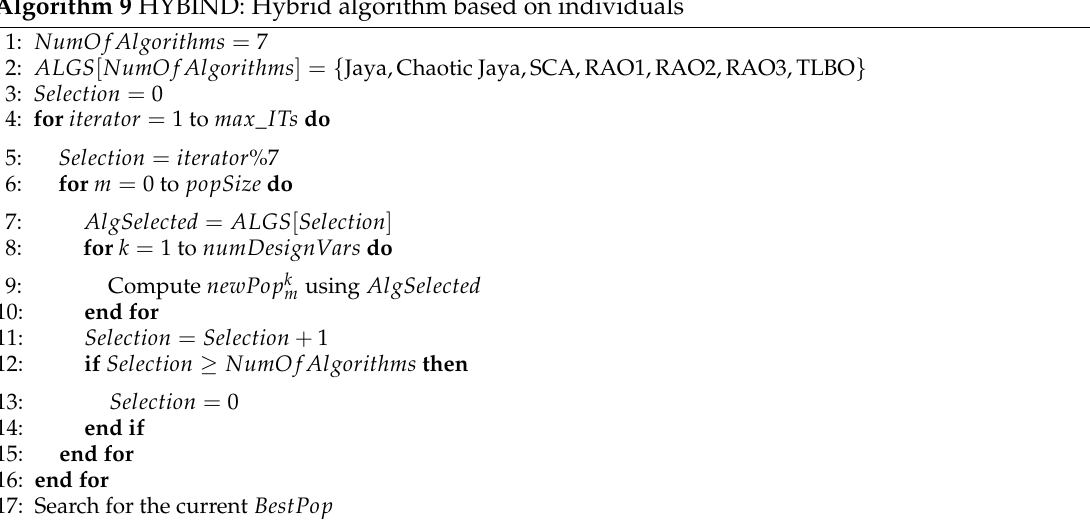
Algorithm 9 HYBIND: Hybrid algorithm based on